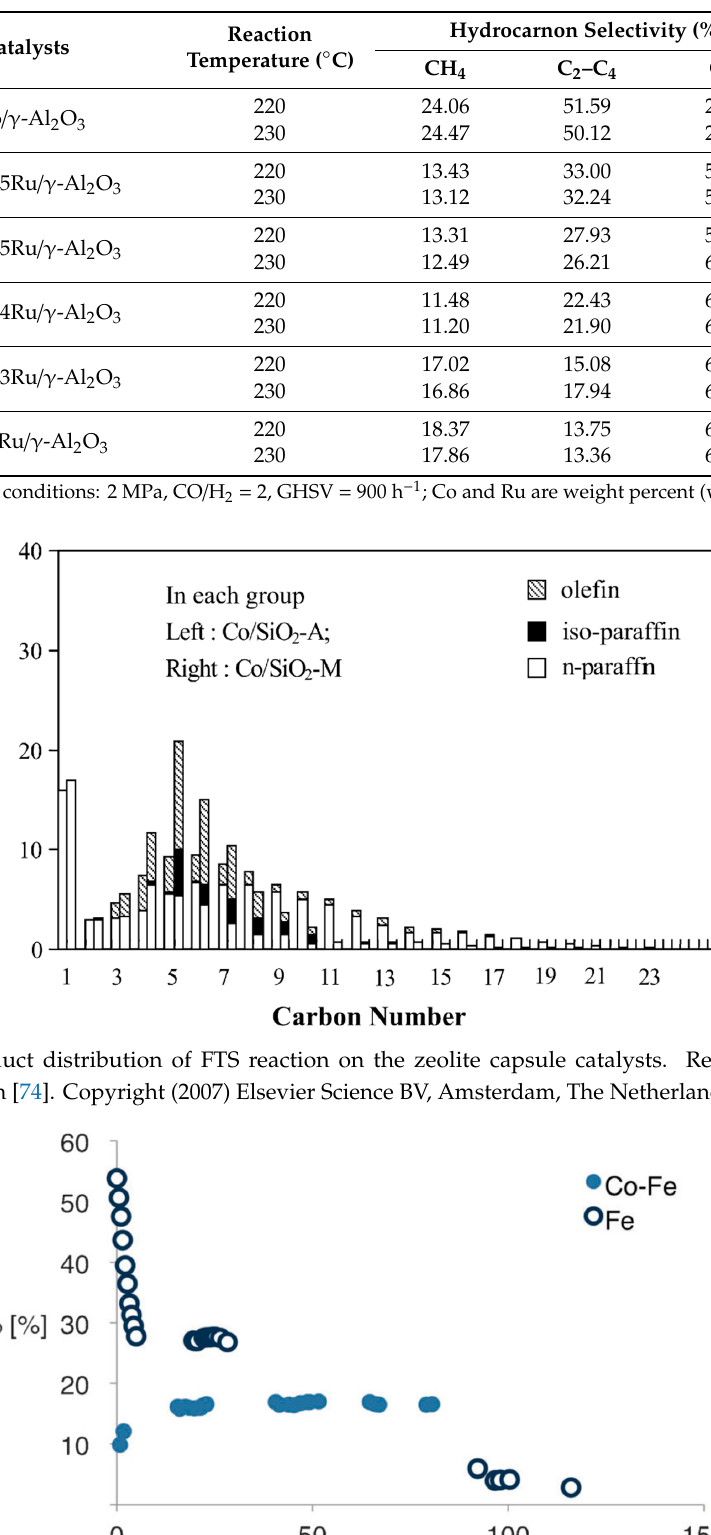
Table 2. FTS product distributions achieved with various synthesized catalysts [85].